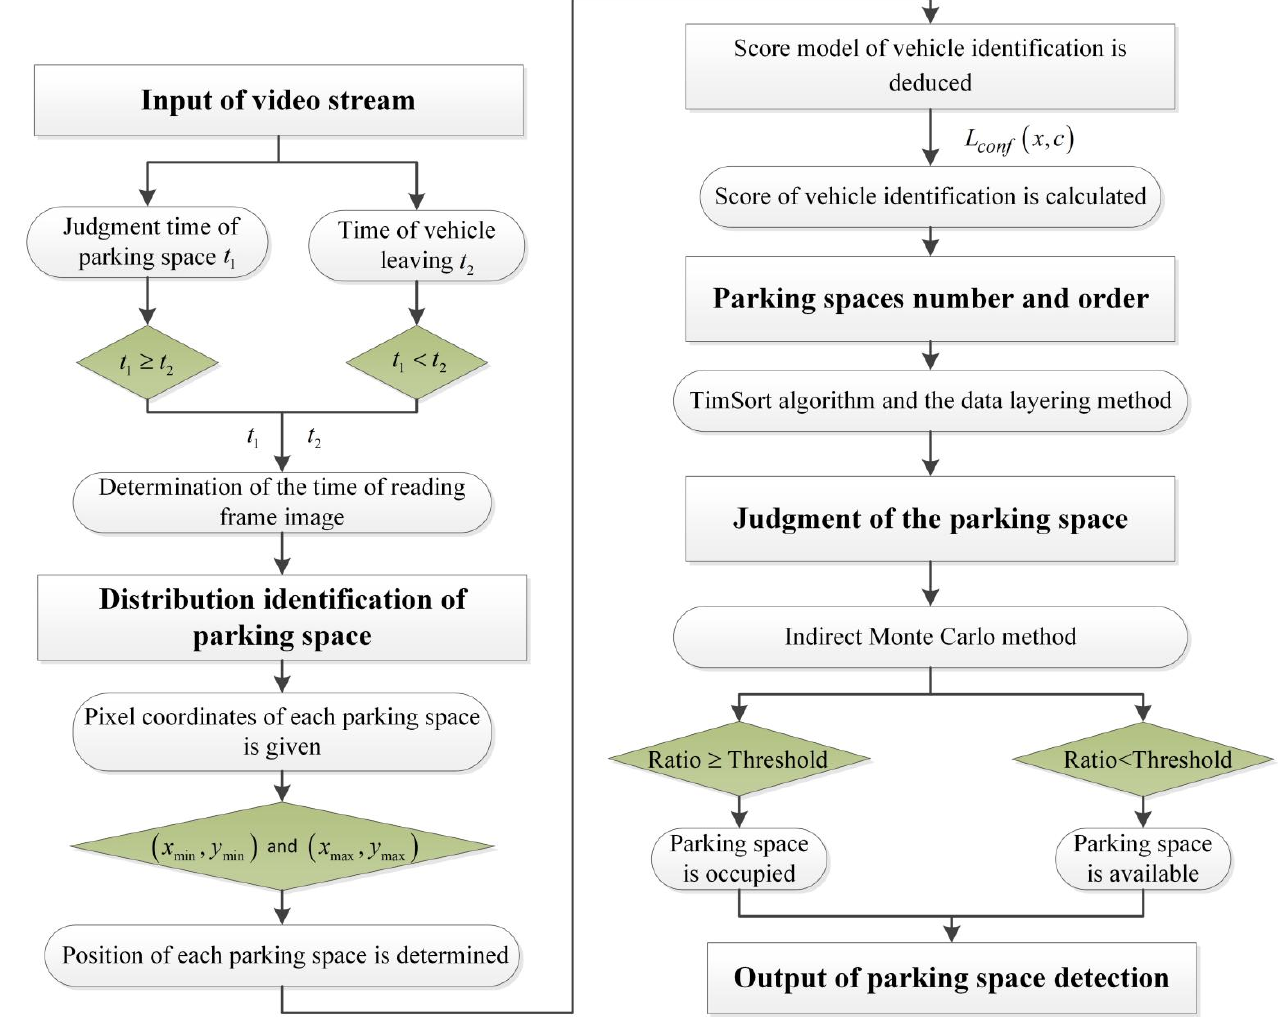
Figure 1. Flowchart of the proposed PSD model.